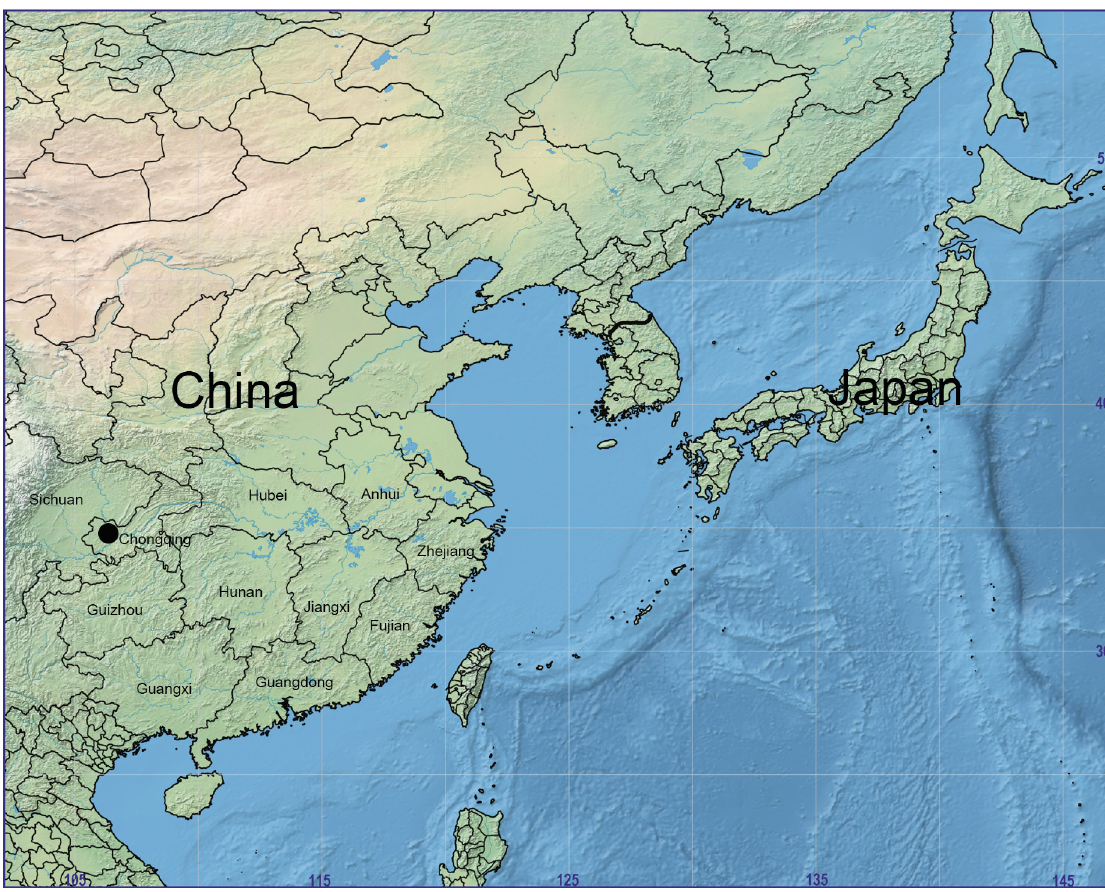
Fig. 8. The type locality of the two new species, Jinyun Mountain,